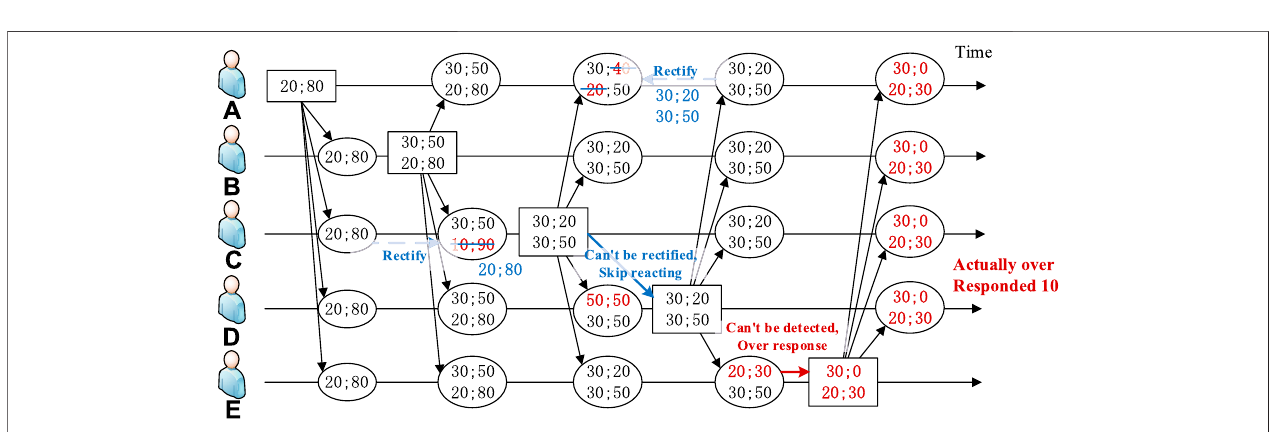
Frontiers in Energy Research |